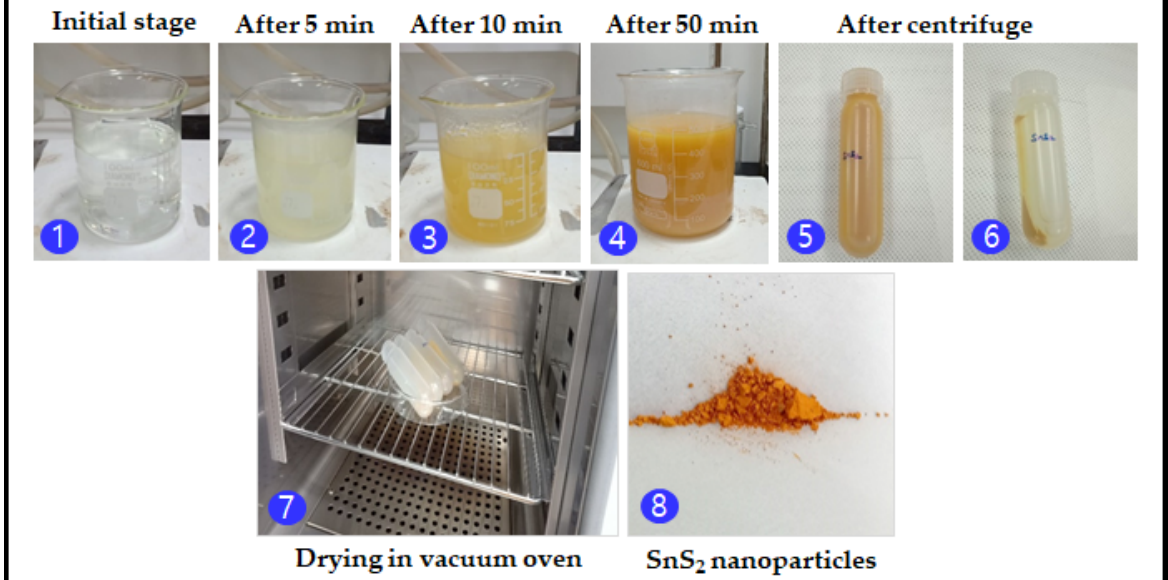
Figure 1. Schematic representation of SnS 2 nanoparticles synthesis.